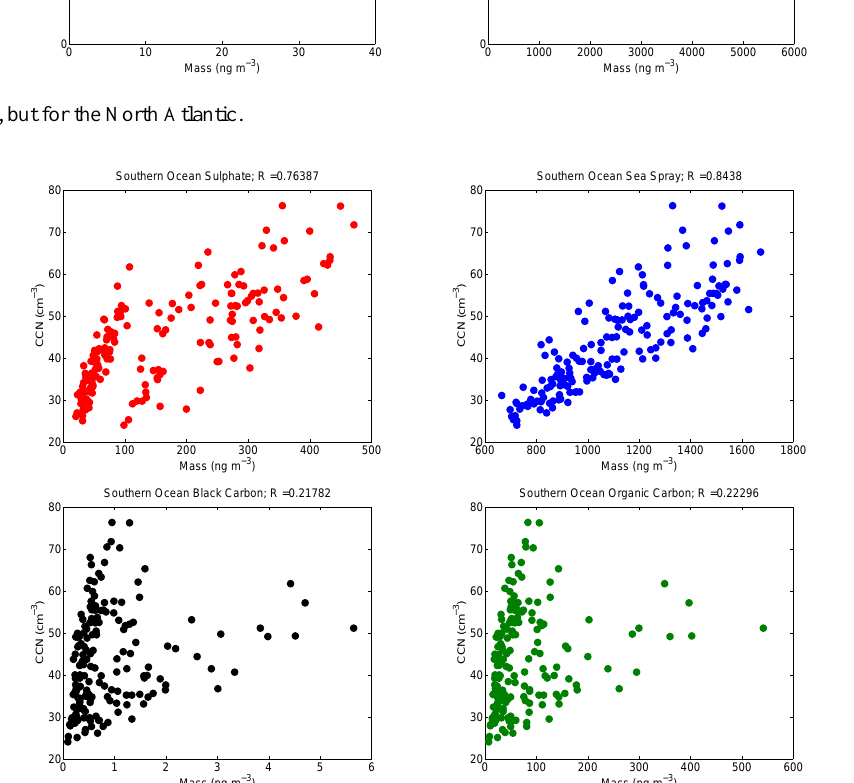
Figure 8. As for Fig. 6, but for the Southern Ocean.